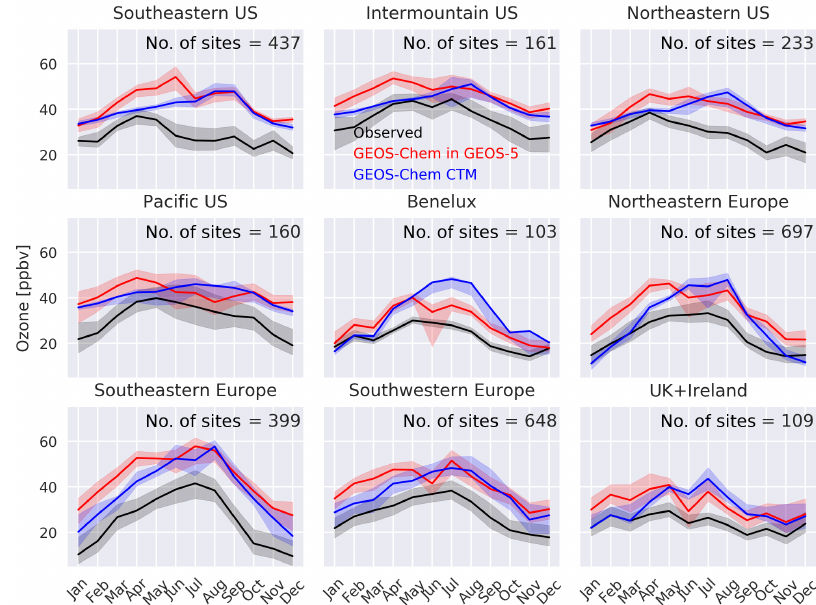
Figure A4. Monthly median ozone concentrations (ppbv; all 24h data) for 2013–2014 at surface sites in the US and Europe, with interquartile range shaded. Surface monitoring sites are grouped according to Fig. A2. Also shown are the GEOS-5 Nature Run with GEOS-Chem chemistry (red) and the offline GEOS-Chem CTM (blue). Hourly model outputs are sampled for the locations and time of observations at the surface (lowest)